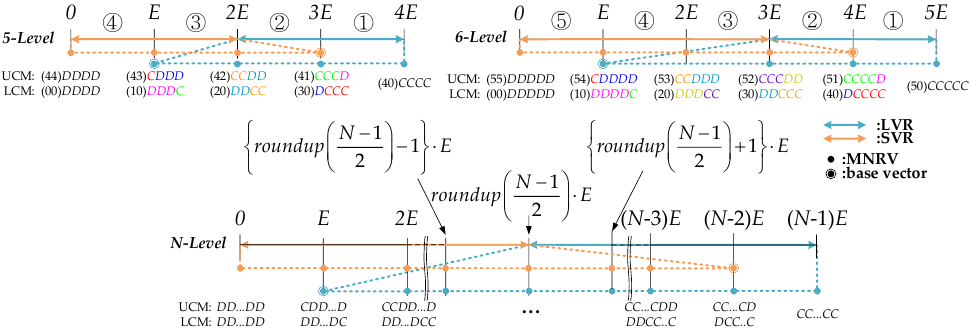
Figure 4. MNRV selection rule according to the V C * position in single-phase full-bridge diode- clamped multilevel topologies.